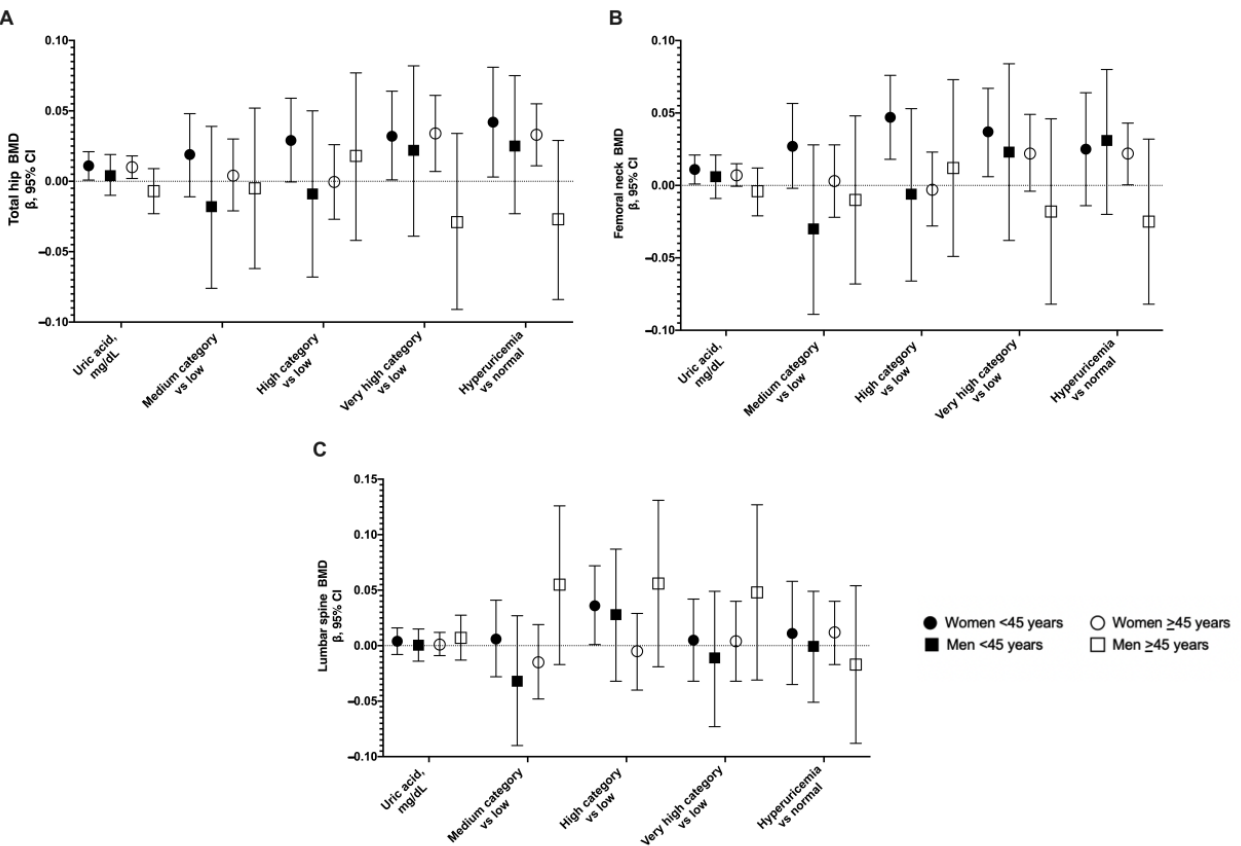
Figure 1. Cross-sectional association between UA and total hip BMD ( A ), femoral neck BMD ( B ), and lumbar spine BMD ( C ). Errors bars represent 95% confidence